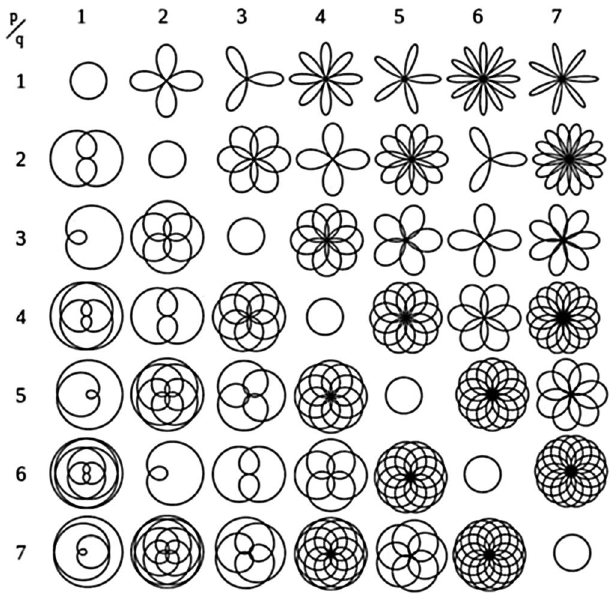
Figure 4. Rhodonea cos p